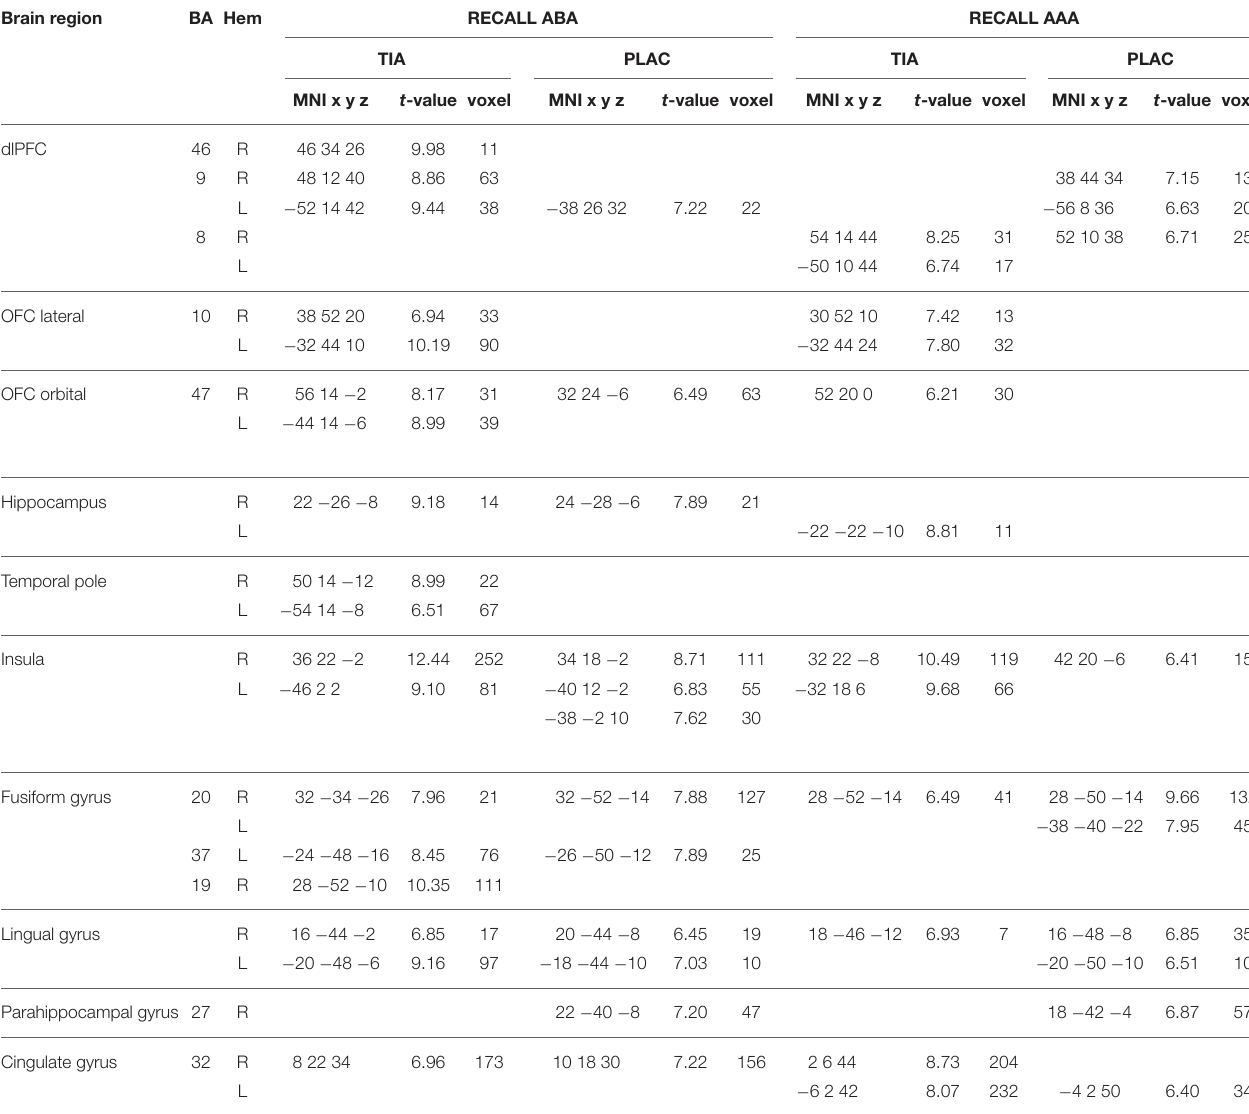
TABLE 2 | One-sample tests—activated regions in TIA and PLAC during Extinction recall p < 0 . 001 FWE-corrected, k = 10 . Brain